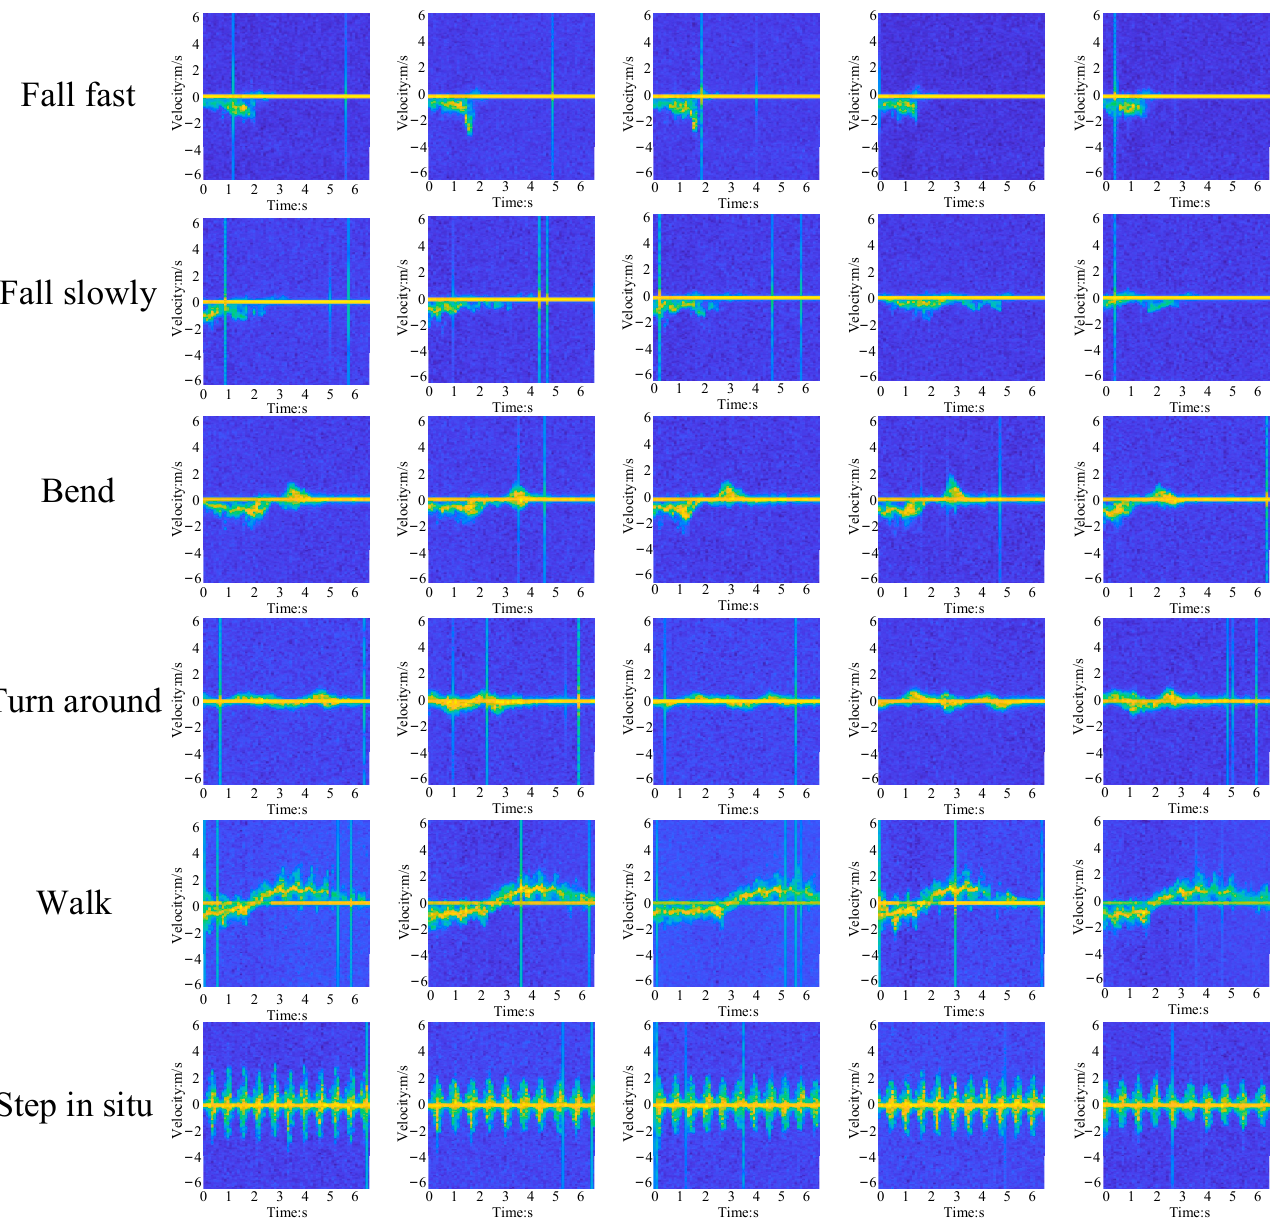
Figure 13. Traditional Micro-Doppler characteristic spectra of different actions.